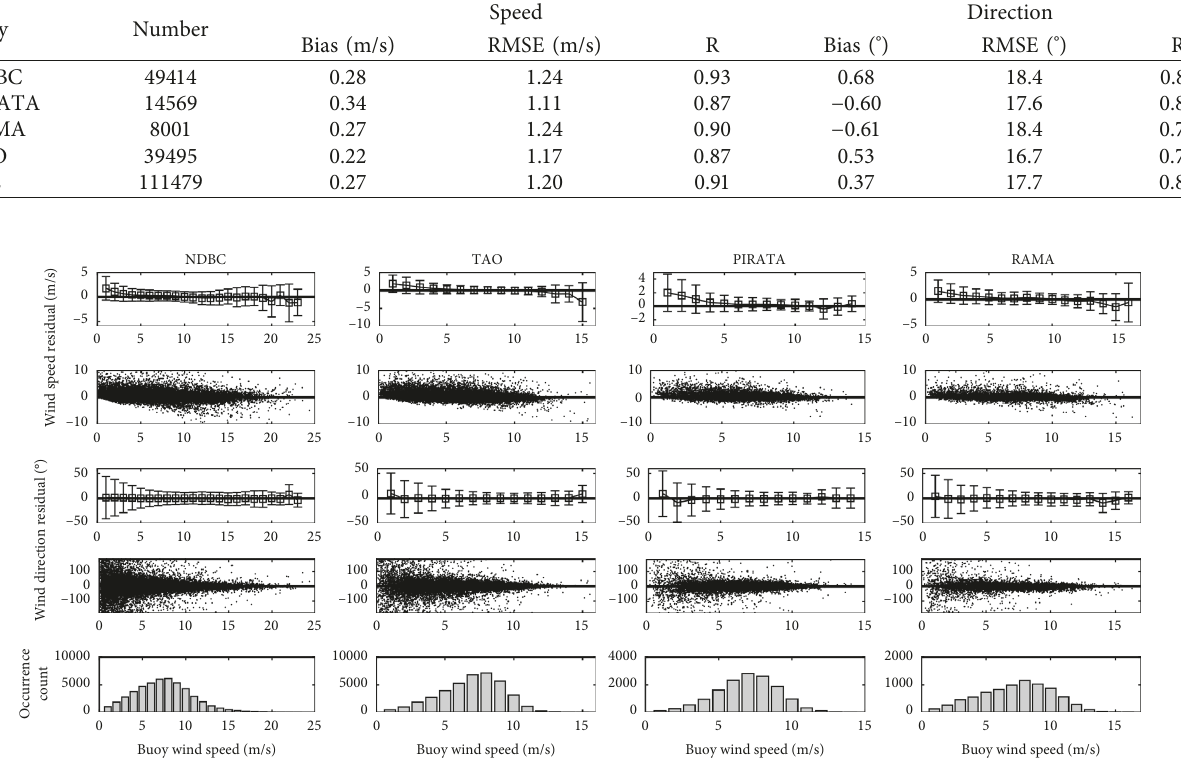
Figure 3: Dependence of statistical parameters of wind speed and direction residuals (OSCAT-buoy) on the buoy wind